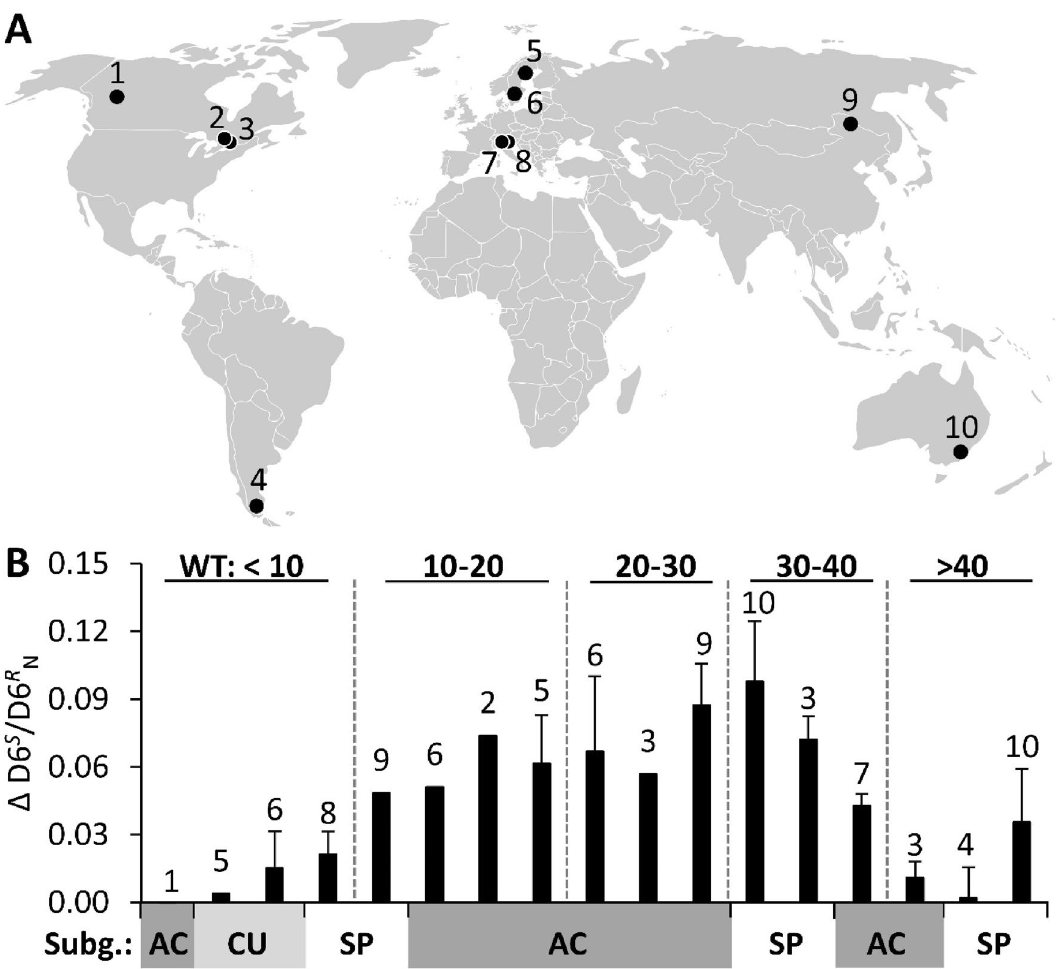
Figure 1. Global changes in the deuterium isotopomer ratio (ΔD6 S / D6 R N ) of Sphagnum during the twentieth century representing changes in the photorespiration to photosynthesis ratio. ( A ) Global distribution of investigated sites. ( B ) Response of the D6 S /D6 R ratio per unit change in 1000/[CO 2 ] between modern and historical Sphagnum samples (ΔD6 S / D6 R N ). Five water table depths (WT) categories (in cm) are indicated by vertical dashed lines. Sphagnum subgenera are indicated on the x-axis by grey/white shading: AC, ACUTIFOLIA (dark grey); CU, CUSPIDATA (light grey); SP, SPHAGNUM (white). Error bars indicate standard error, n = 1–4 (see Table S1 for more information). Numbers above error bars correspond to sample sites as numbered in ( A ).